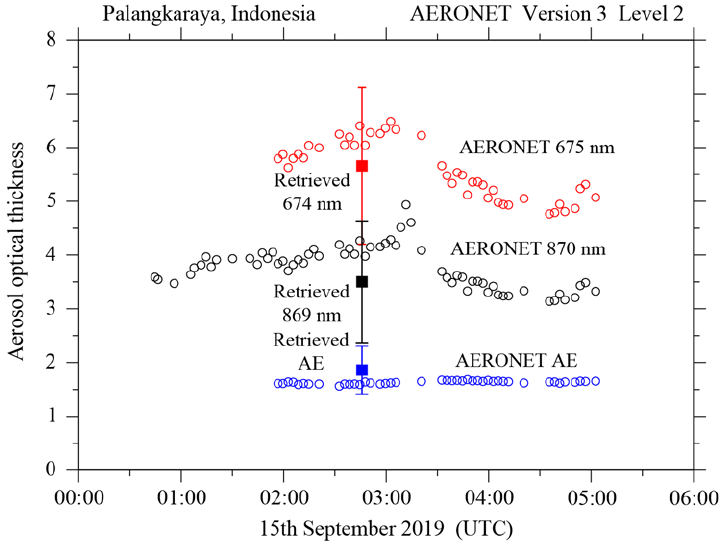
Figure 7. Aerosol optical thickness AOT (674 nm), AOT (869 nm), and Ångström exponent (AE) are depicted as red, black, and blue, respectively. The open circles represent AERONET measure- ments and the filled squares were retrieved from the second-generation global imager (SGLI) on 15 September 2019.